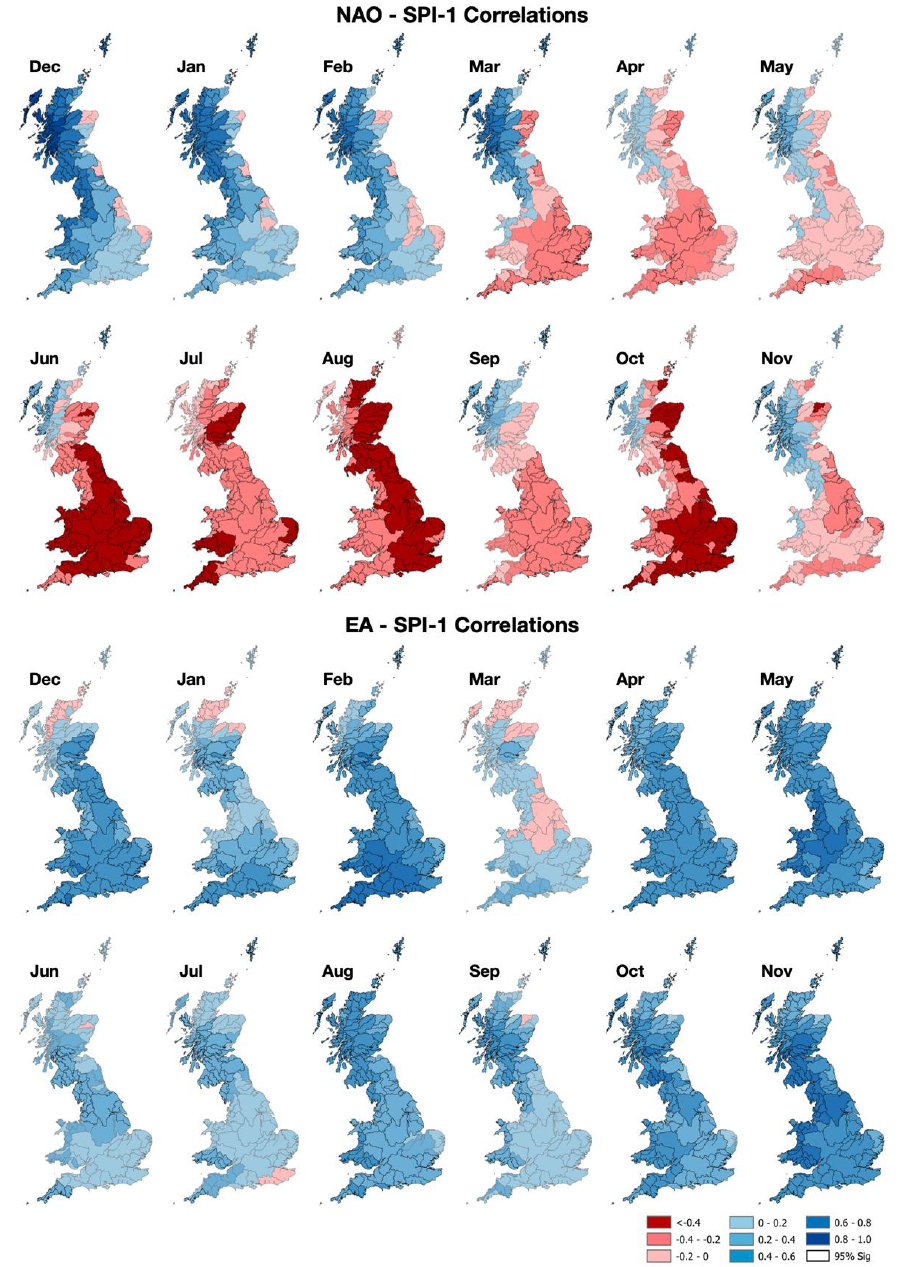
Figure 2. Monthly correlation coefficients for the period January 1950–December 2015 between the NAO and EA teleconnection indices and the SPI-1 values at the IHU Group level. IHUs with a darker outline indicate 95% significance ( p value ≤